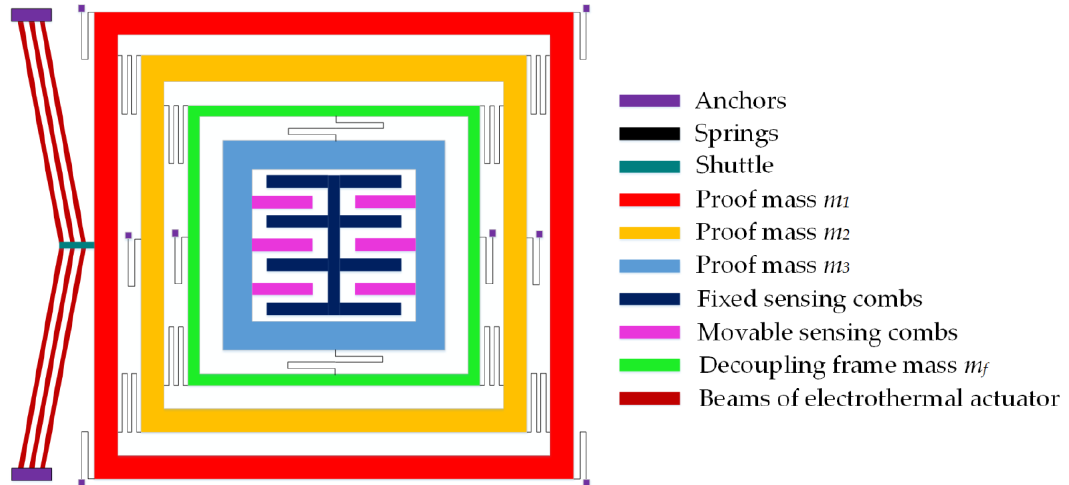
Figure 1. Schematic diagram of the proposed 4-DOF MEMS gyroscope with a 3-DOF drive mode and 1-DOF sense mode oscillator.